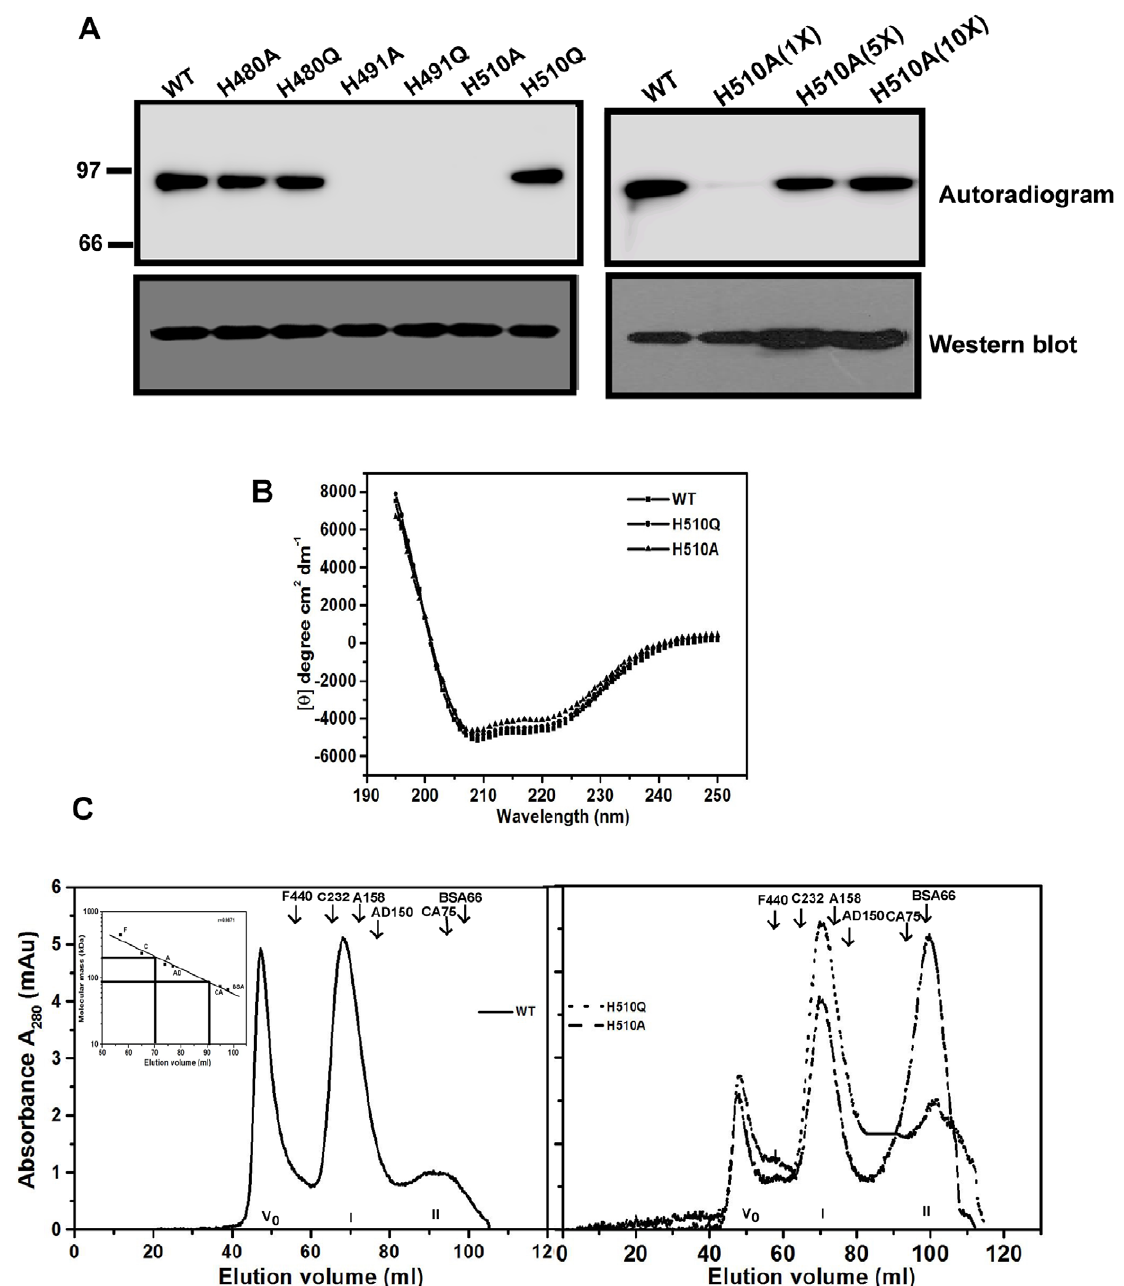
Figure 1. mPPK1 autophosphorylates at His-491 residue. A. Autophosphorylating ability of mPPK1 in response to mutations at conserved histidine residues. Upper left panel: Autophosphorylation activities of wild-type ( lane 1) and mutant proteins ( lanes 2–7) using 500 ng protein/ reaction. Upper right panel: Autophosphorylation of H510A mutant protein with increasing concentrations (1X=500 ng; 5X=2.5 m g and 10X=5 m g) of protein. Western blotting of mutant proteins was carried out using anti-His antibody (lower left and right panels). B. Far-UV CD spectra of mutant proteins. C. Gel filtration elution profile of wild-type (WT) and mutant (H510A and H510Q) proteins. V o indicates void volume. I and II represent the molecular mass corresponding to dimeric and monomeric forms of mPPK1 respectively. Inset: Molecular mass calibration curve using different proteins. Notation used: F, Ferritin (440 kDa); C, Catalase (232 kDa); A, Aldolase (158 kDa); AD, Alcohol dehydrogenase (150 kDa); CA, Conalbumin (75 kDa) and BSA, Bovine serum albumin (66 kDa). Position of molecular mass markers is indicated.